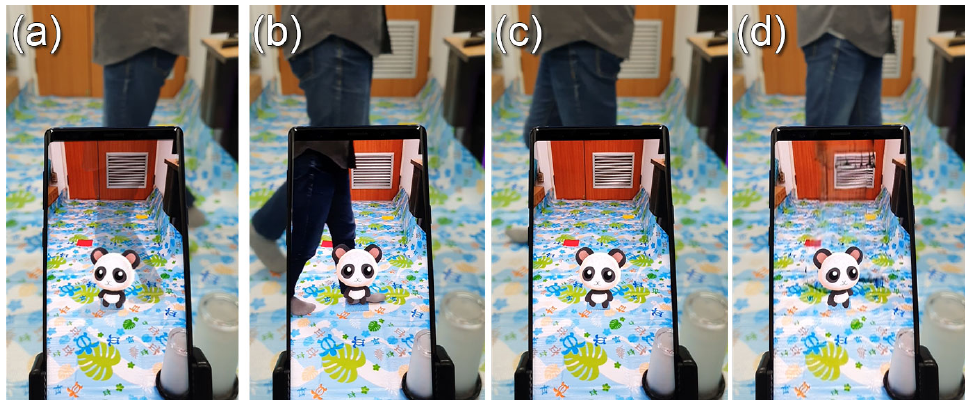
Figure 1. The varying degrees of diminished representation of the content-irrelevant real object: ( a ) semi-transparent, ( b ) default (as is), ( c ) transparent (ideal/ground truth), and ( d ) removed and inpainted by a real-time algorithm. The work of [7] compared conditions ( a – c ); and this work compares ( b – d ),